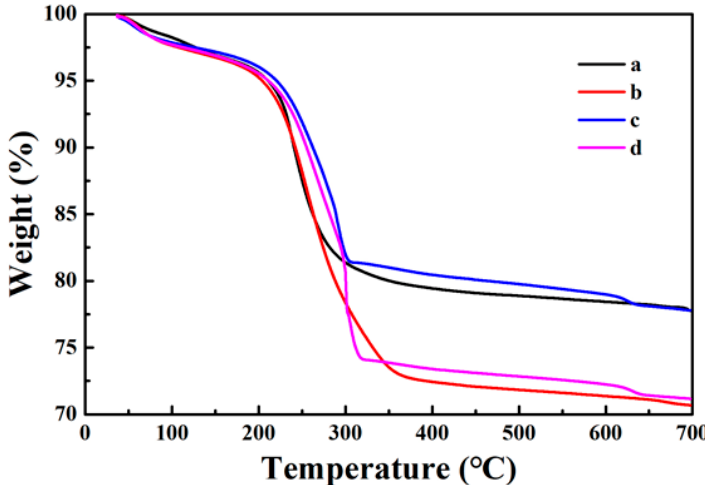
Figure 6. TG curves of the as-prepared samples Fe 3 O 4 ( a ), Fe 3 O 4 @PDA ( b ), Fe 3 O 4 @PDA / Ag ( c ), and Fe 3 O 4 @PDA / Ag / PDA ( d ) nanospheres.